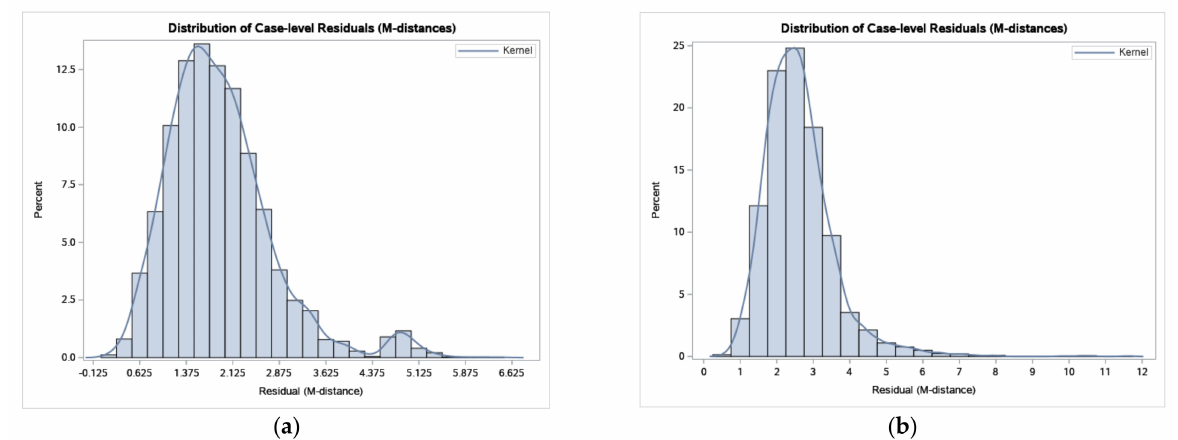
Figure 7. Distribution of residuals ( a ) pre-trial data set, ( b ) post-trial data set. With the p-p plots, we obtained a higher resolution in the center of the